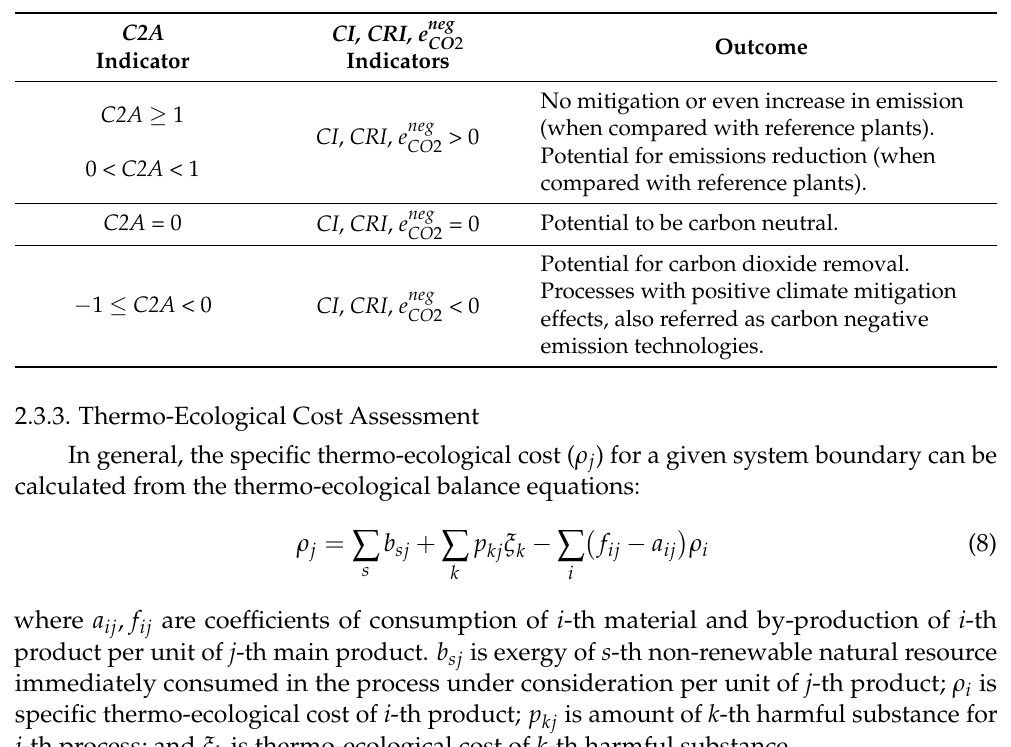
Table 3. Indicators interpretation